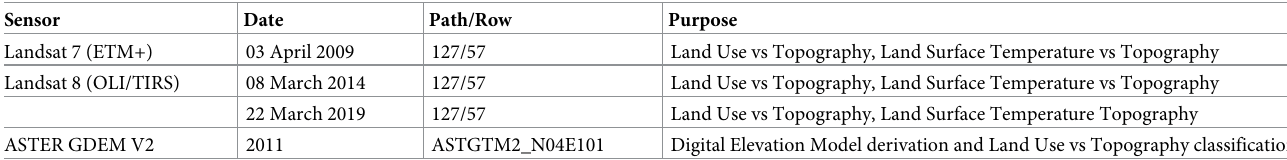
Table 1. Description of satellite sensors and acquisition